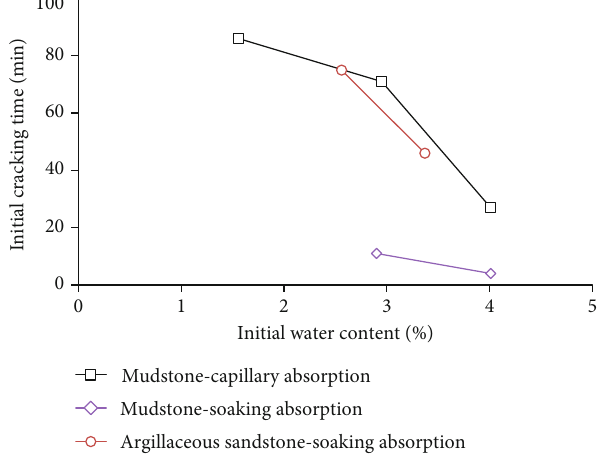
Figure 12: Curves between initial cracking time and initial water content